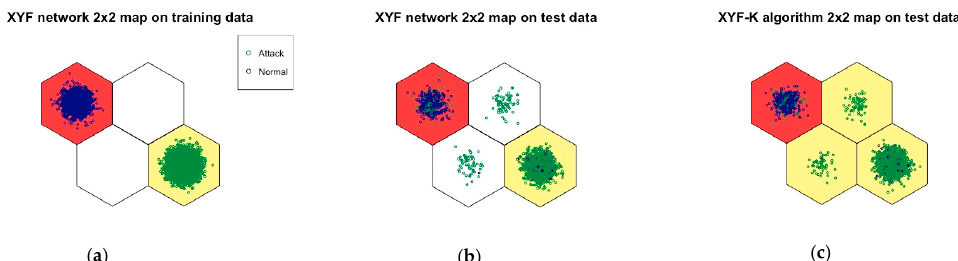
Figure 6. XYF network and XYF – K algorithm on the different neurons map sizes for the fuzzy dataset. ( a ) XYF network 2 × 2 map on training data; ( b ) XYF network 2 × 2 map on test data; ( c ) XYF-K algorithm 2 × 2 map on test data; ( d ) XYF network 4 × 4 map on training data; ( e ) XYF network 4 × 4 map on test data; ( f ) XYF-K algorithm 4 × 4 map on test data; ( g ) XYF network 8 × 8 map on training data; ( h ) XYF network 8 × 8 map on test data; ( i ) XYF-K algorithm 8 × 8 map on test data.